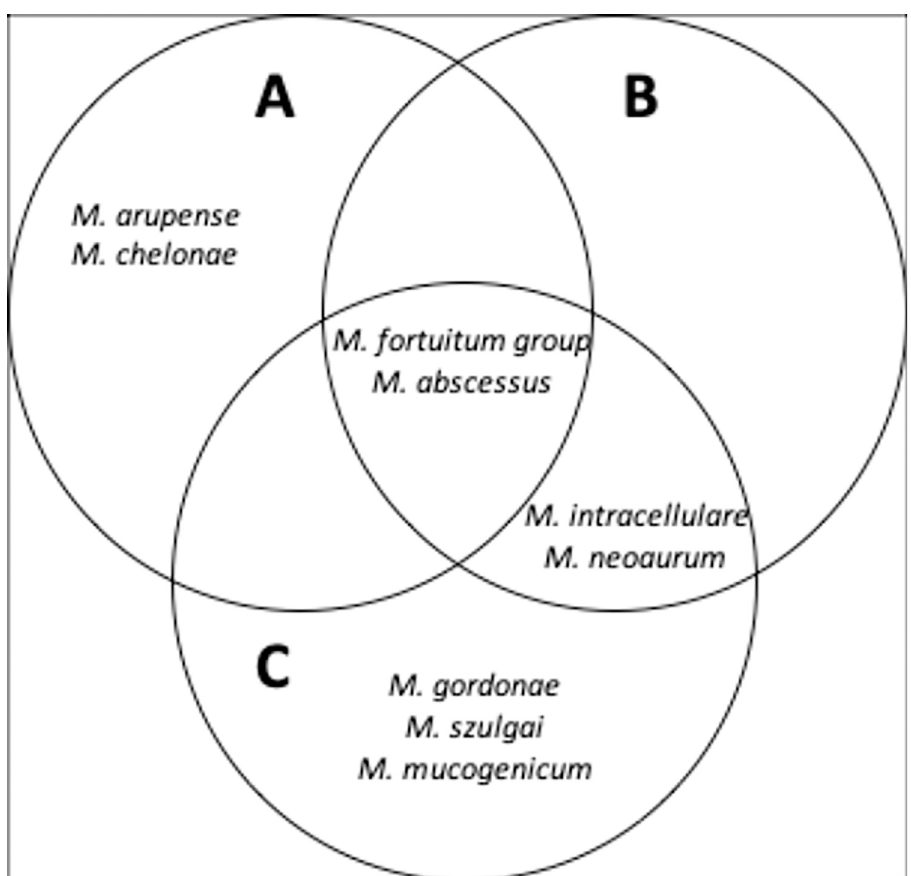
Fig 1. Distribution of NTM species in Java. (A) Types of NTM species in Surabaya-East Java. (B) Types of NTM species in Semarang-Central Java. (C) Types of NTM species in Bogor-West Java.